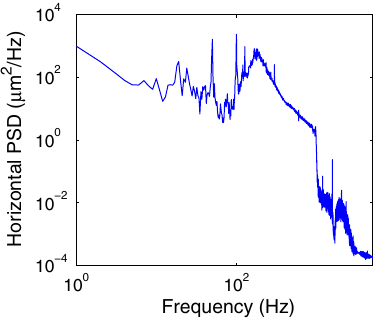
FIG. 9. Synchrotron frequency measurements made for V rf ¼ ¼ (cid:1) 7 (cid:5) 10 (cid:1) 7 . The corresponding natural elec- 3 : 4 MV and (cid:3) 1 tron bunch length is 0.6